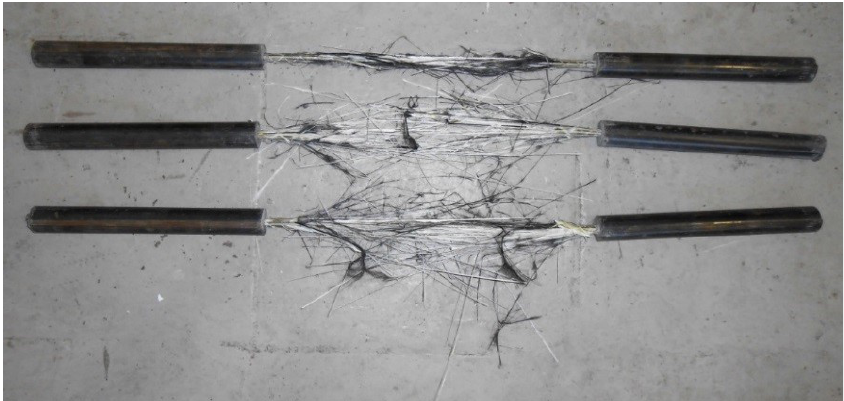
Figure 4. ACC K samples after the rupture test −